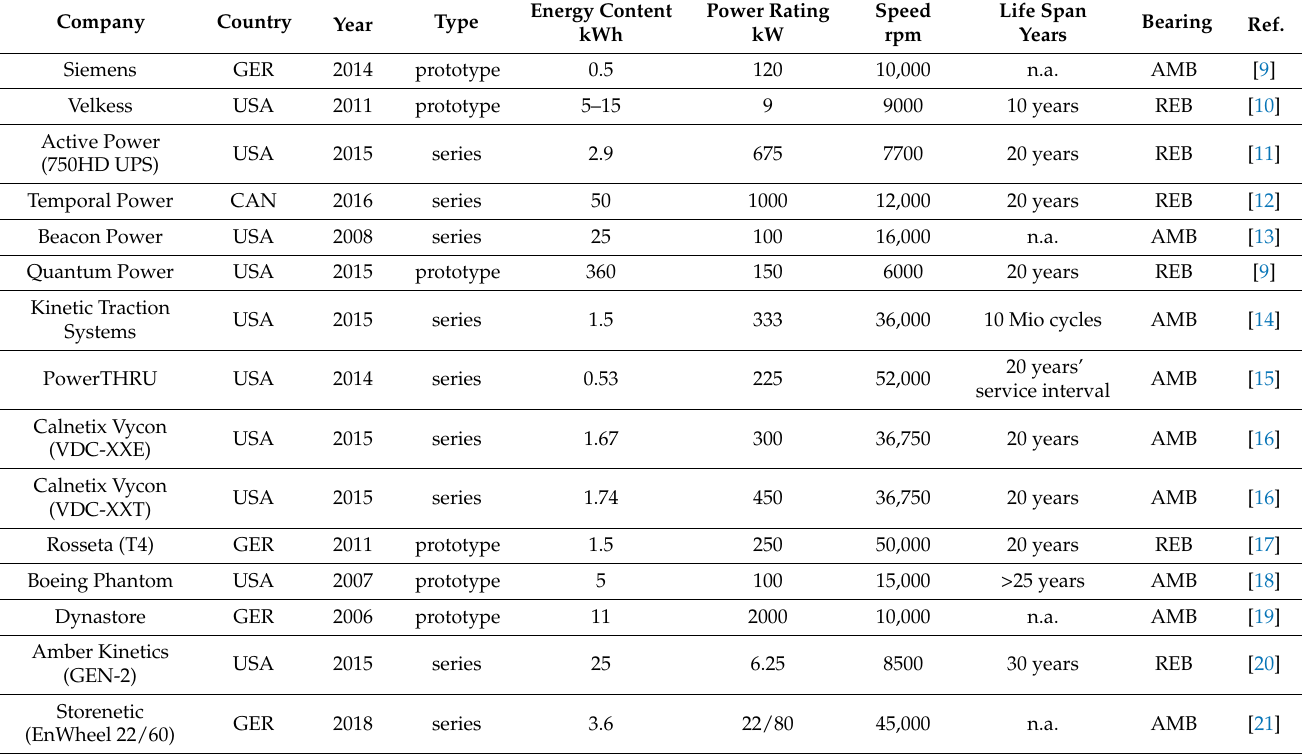
Table 1. Overview of most commercially available and prototype FESS and their main characteristics including used bearing